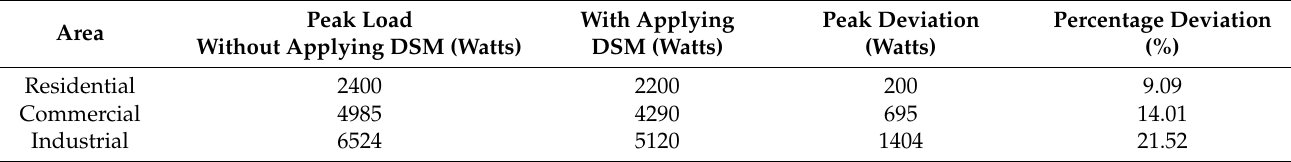
Table 11. Comparison of peak demand reduction during winter.